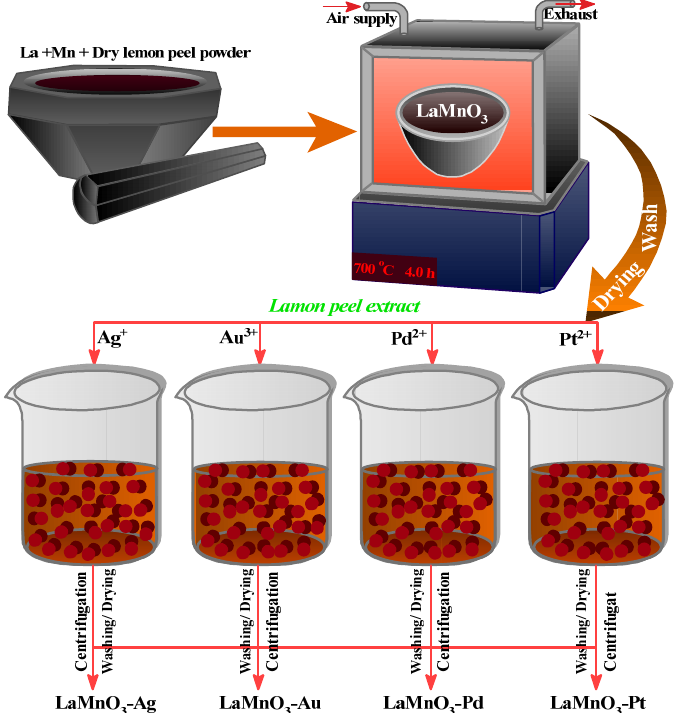
Figure 1. Schematic representation of the preparation of bulk and noble metal deposited LaMnO 3 catalysts.